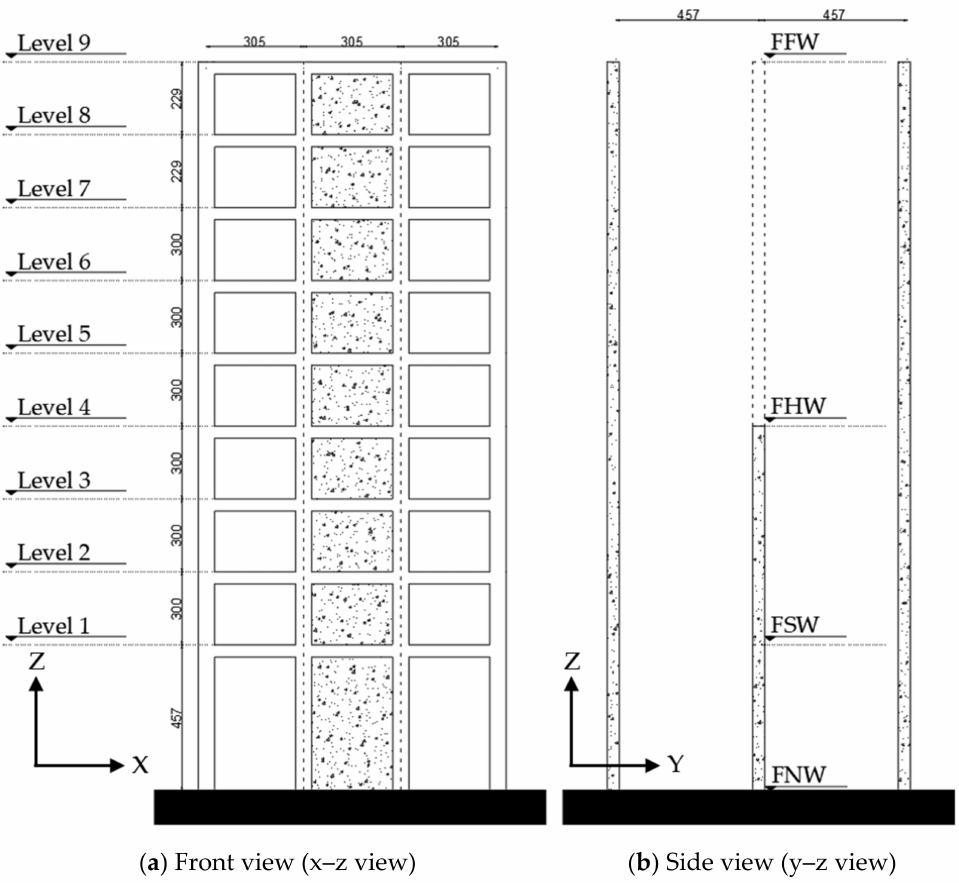
Figure 2. Elevation view of the test specimen by Moehle and Sozen (dimension in mm).